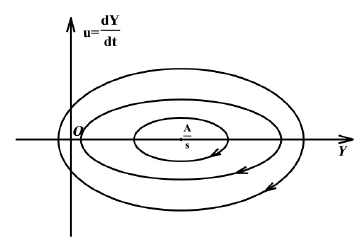
Fig. 3 Differential equation model of economic adjustment